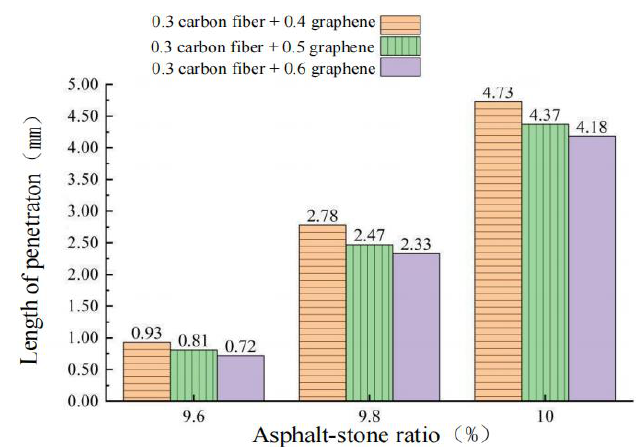
Figure 13. Test results of penetration with different oil–stone ratio.